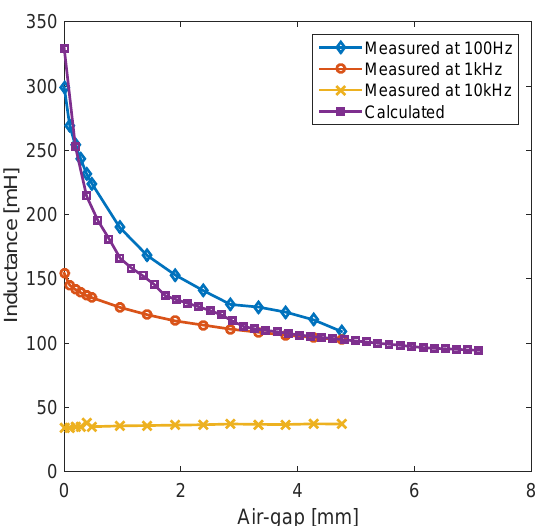
Figure 11. Comparison between calculated inductance (using the rise-time measurements) and measured inductance (using an Agilent-U1732A) at different air-gaps. Measurements were made at three different excitation frequencies using the hand-held inductance